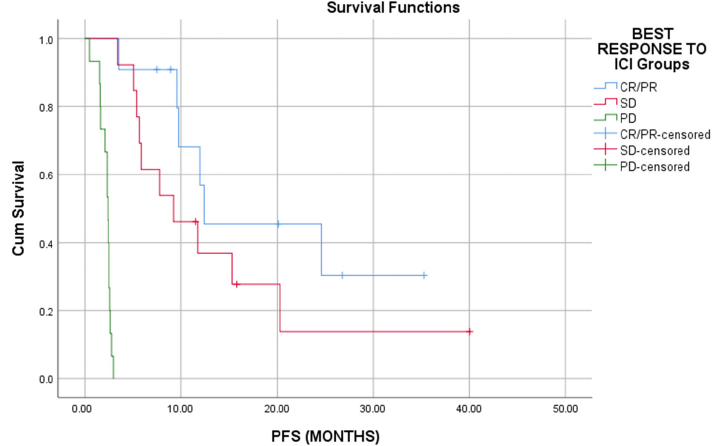
Figure 2. Responders to ICI have better progression free survival as compared to that of nonresponders ( p < 0.01).